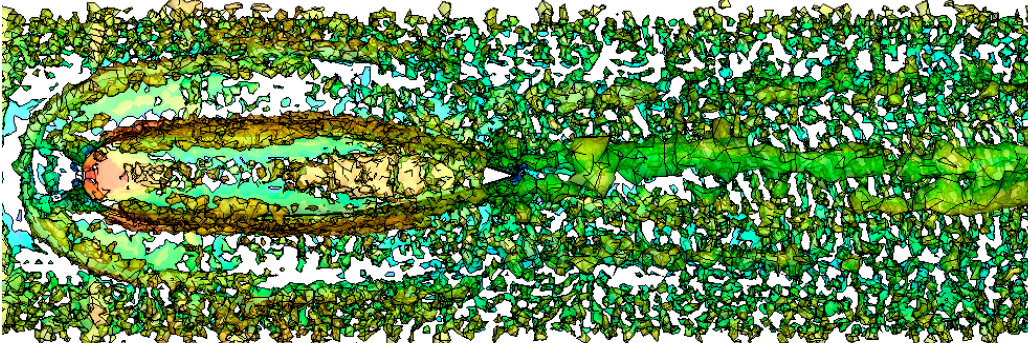
Figure 16. The diagram of the horseshoe vortex of the model with triangular VGs.